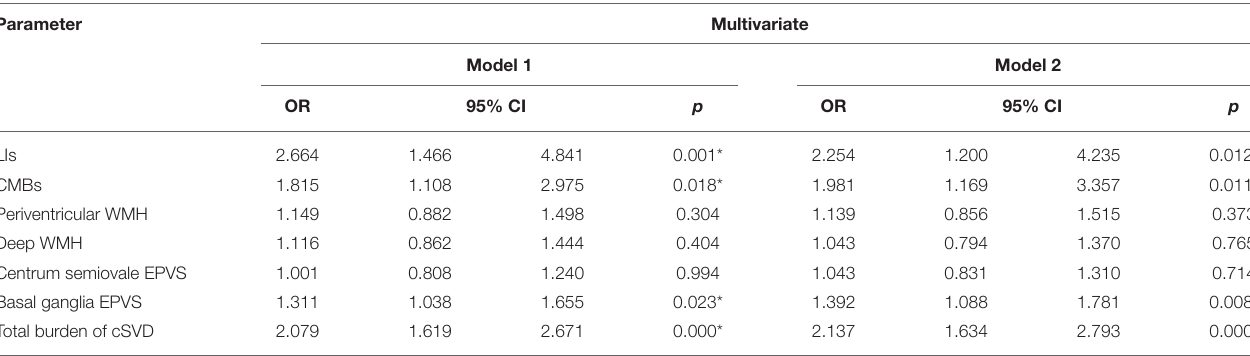
TABLE 3 | Multivariate logistic regression analysis between the cSVD and PSD. Parameter